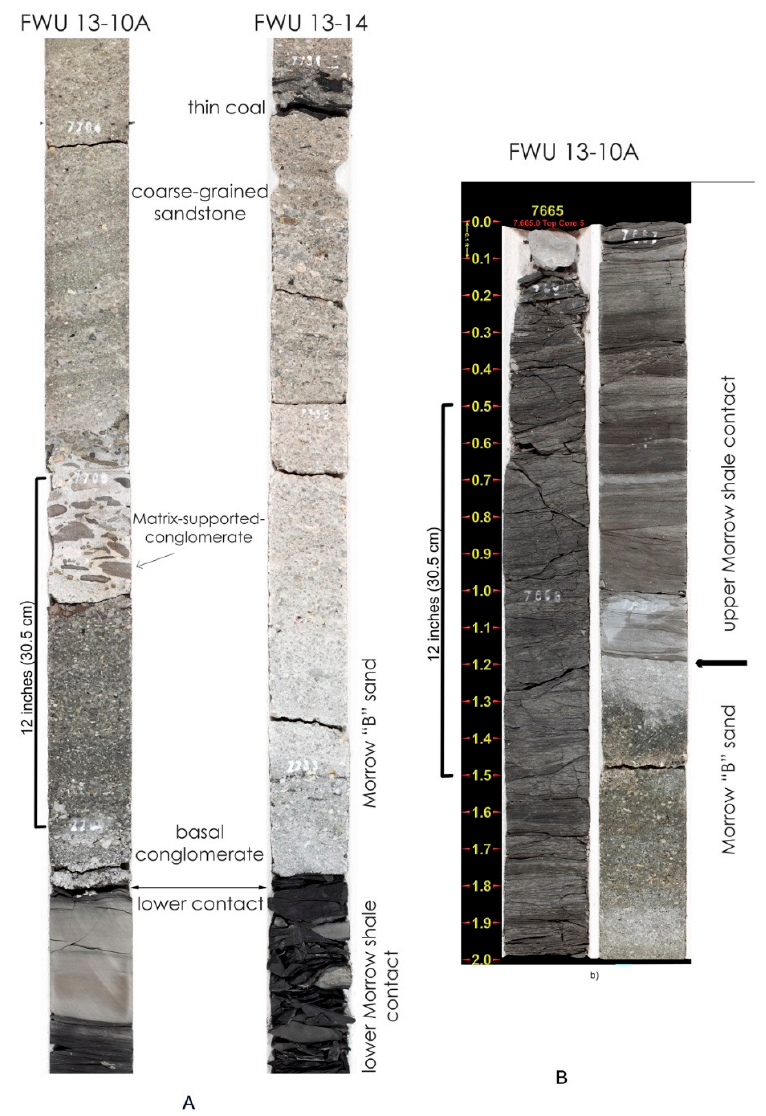
Figure 5. ( A ) Lower part of Morrow B core from wells 13-10A, left, and 13-14, right, showing contact with the underlying Morrow shale and the basal conglomerate grading up into coarse sandstone. Core slabs are ~10 cm (4 inches) wide. One-foot intervals marked on cores; ( B ) sharp contact between Morrow B sand and overlying upper Morrow shale in well 13-10A. There is approximately 11.5 m (38 ft) of Morrow B reservoir sandstone between the upper and lower shale contacts in well 13-10A. Basal conglomerates grade upwards into an overlying coarse-grained sandstone